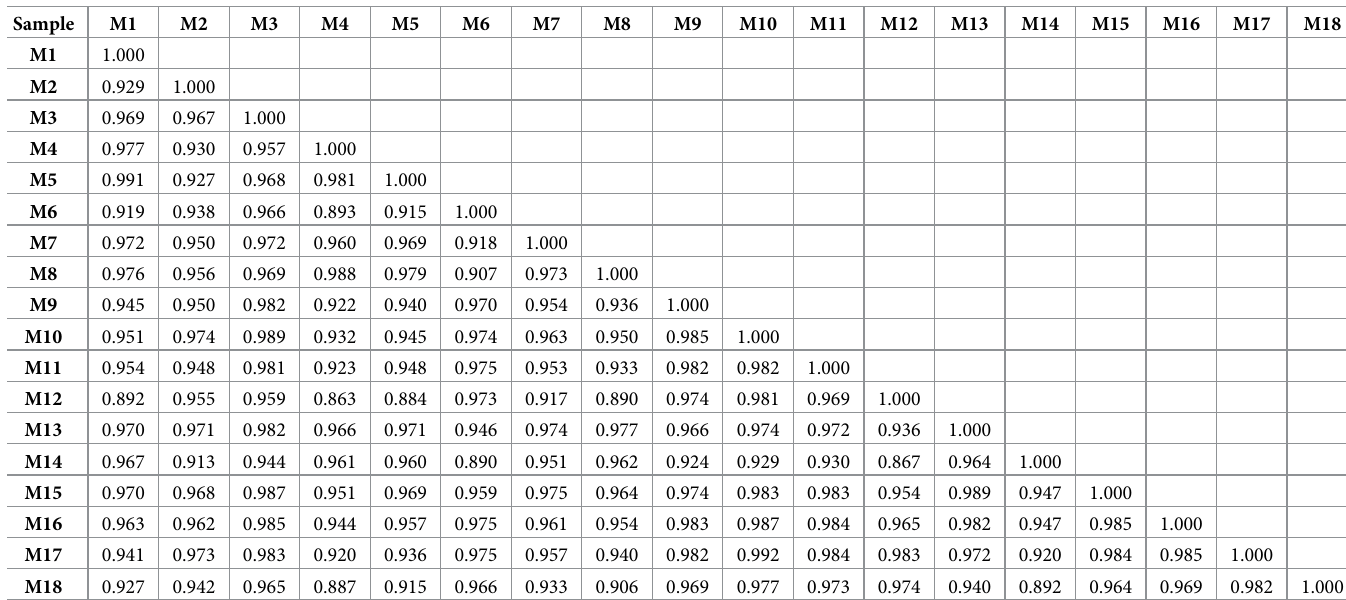
Fig 1. The FTIR spectra of M1 ~ M18. https://doi.org/10.1371/journal.pone.0278113.g001 Table 2. Similarity analysis of FTIR spectrum of